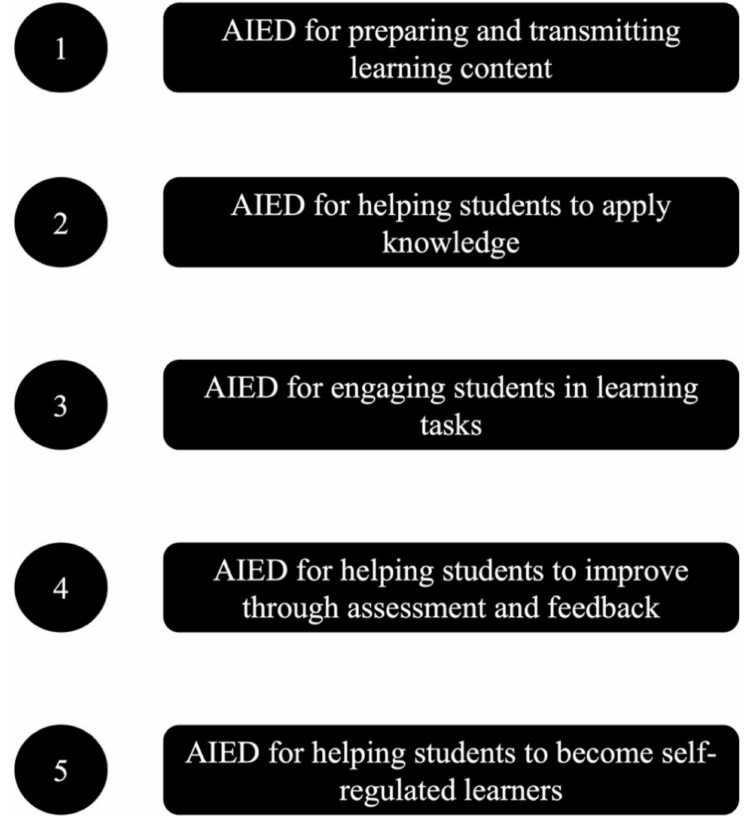
Figure 6. The five aspects of teaching and learning (adapted from